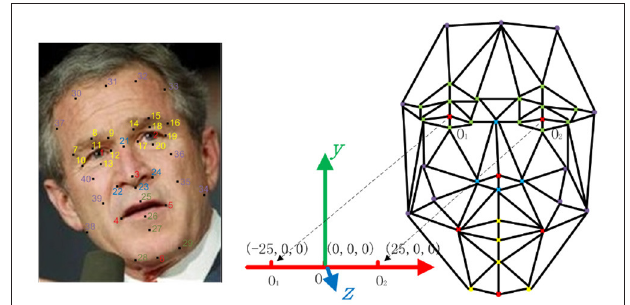
FIGURE 4 | Face structure defined by 40 feature points: the left side shows the point positions in a face image; the right side shows the structure topology with eye center points of O 1 ( 25, 0, 0) and O 2 (25, 0, 0) in 3 D space, which − looks like a frontal 2D face structure from the direction of normal (0, 0, 1). (The face image used in the figure comes from LFW database 1